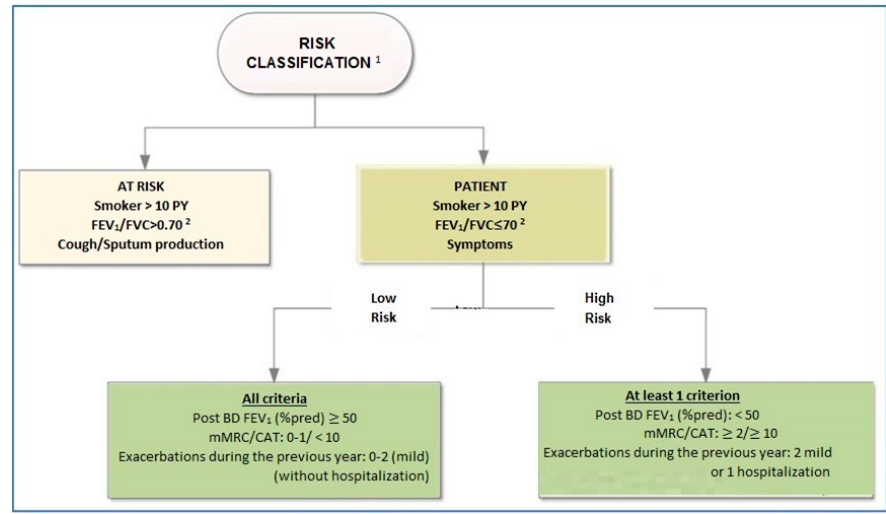
Figure 1. Steps in the treatment of COPD. Abbreviation: COPD, chronic obstructive pulmonary disease. 1 Evaluate comorbidities carefully. 2 Use the Lower Limit of Norma, (LLN) in borderline values especially in patients bellow 45 and over 80 years of age.